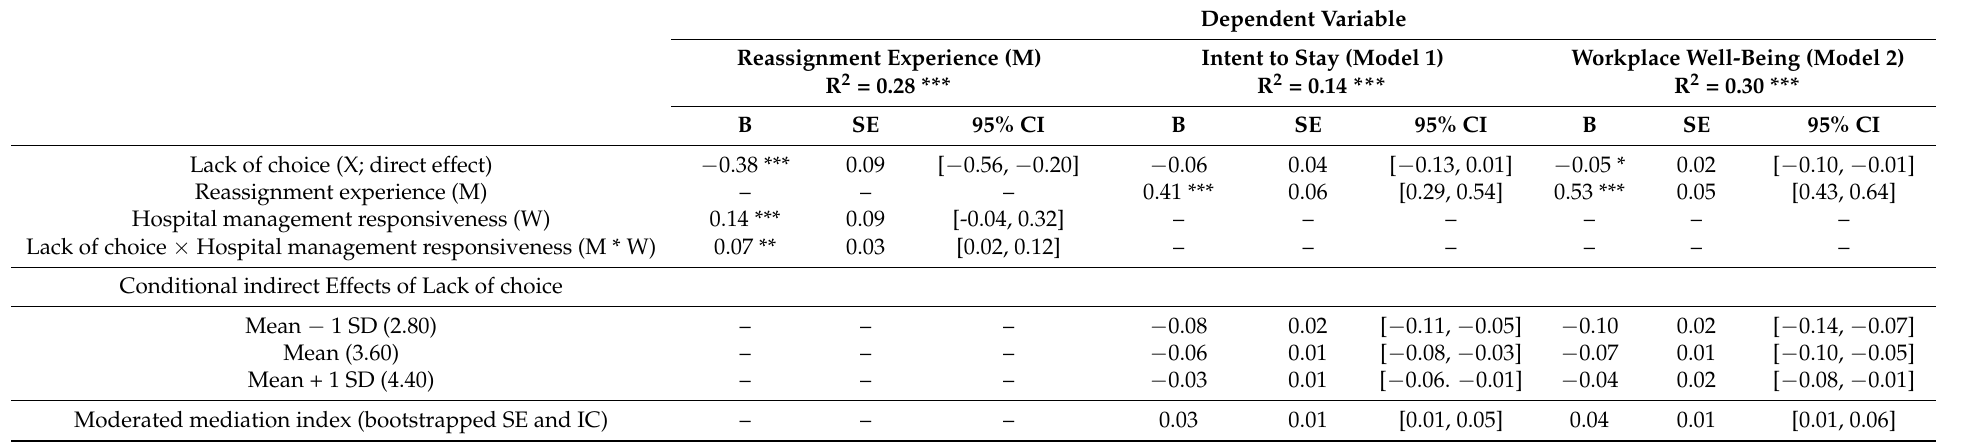
Table A1. Regression coefficients and conditional direct and indirect effects for the moderated mediation